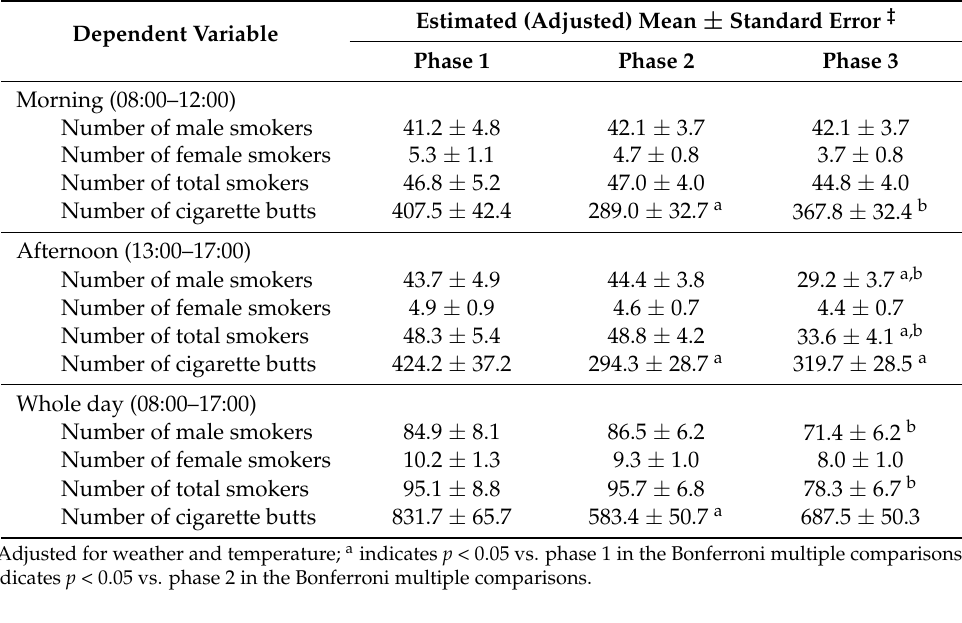
Table 1. Effect of smoking reduction education on the number of smokers and cigarette butts outside of the target hospital.